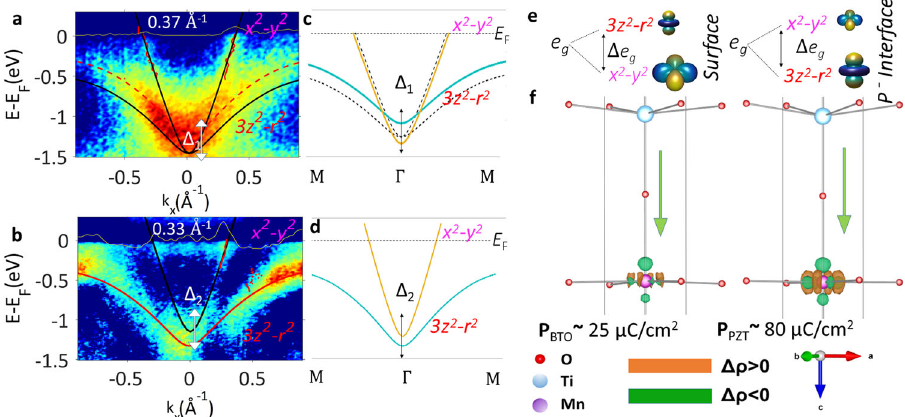
Fig. 4 Orbital polarization. Angle-resolved photoelectron spectroscopy (ARPES) images along the Γ M direction measured at the enrgy hv = 643 eV and s-polarized light for ( a ) La 0.7 Sr 0.3 MnO 3 (LSMO), and ( b ) at the PbZr 0.2 Ti 0.8 O 3 (PZT) interface, PZT|LSMO. The momentum distribution curves (MDCs) at the Fermi energy (E F ) (yellow lines) are used to extract the Fermi wavevectors (k F s). The superimposed band calculations for strained LSMO are rigidly shifted for PZT|LSMO in order to match the experimental k F . The splitting between the e g orbitals of LSMO Δ 1,2 e g in the Γ point measures energy separation of the (3z 2 -r 2 ) and (x 2 -y 2 ) - derived bands. The sketch of the corresponding ARPES dispersions for bare LSMO assuming degenerate e g orbitals (dotted line) and surface-lifted degeneracy ( c ) and PZT|LSMO interface ( d ) is based on the corresponding energies of the (3z 2 -r 2 ) - and (x 2 -y 2 ) orbitals at the surface and at the interface ( e ). f Density functional theory (DFT) slab calculations of the interface charge density for BaTiO 3 (BTO) interface, BTO| LSMO and PZT|LSMO shows how the modulation of charge carrier density in the fi rst LSMO unit cell depends on the magnitude of the inwards P −